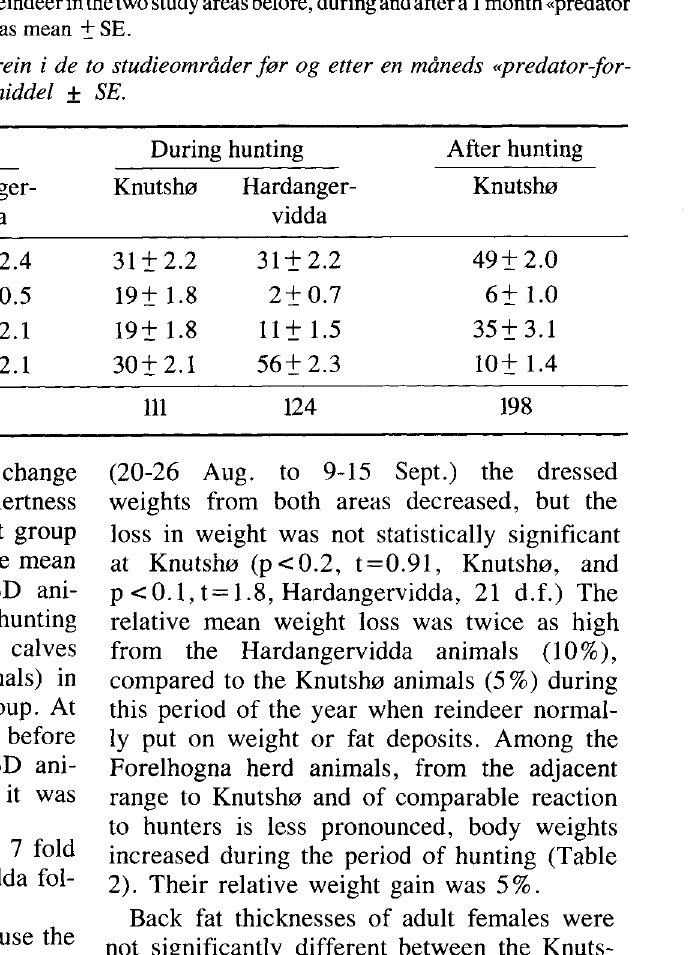
Table 1. Percentage daily activity time for wild reindeer in the two study areas before, during and after a 1 month «predator disturbance» period. Activity is given as mean + SE.